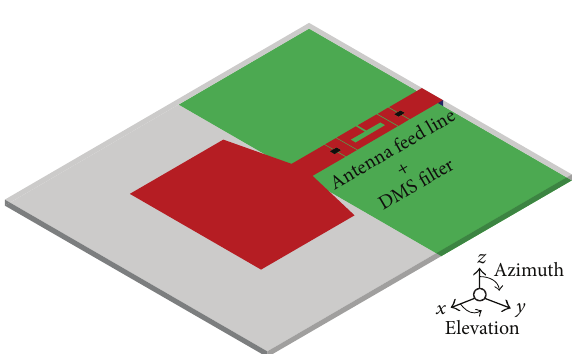
Figure 8: The reconfigurable filtenna concept.